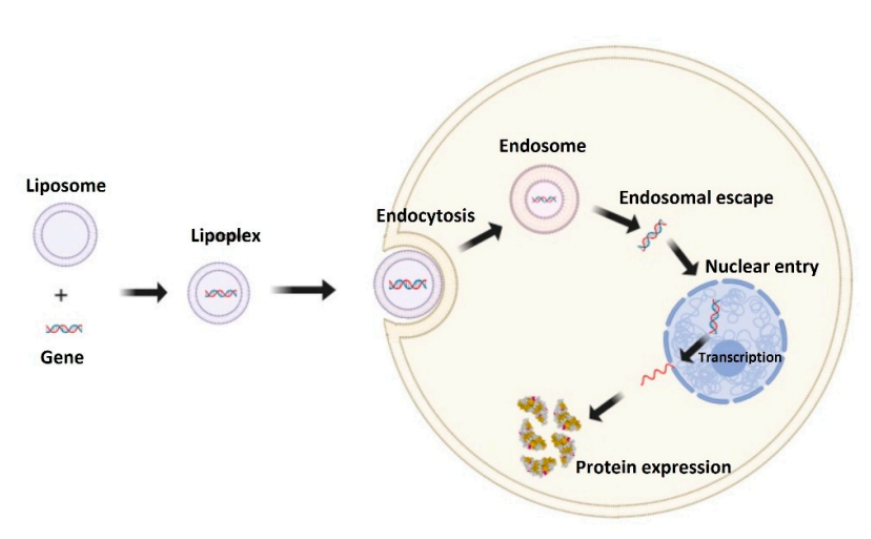
Figure 2. Mechanism of liposomal